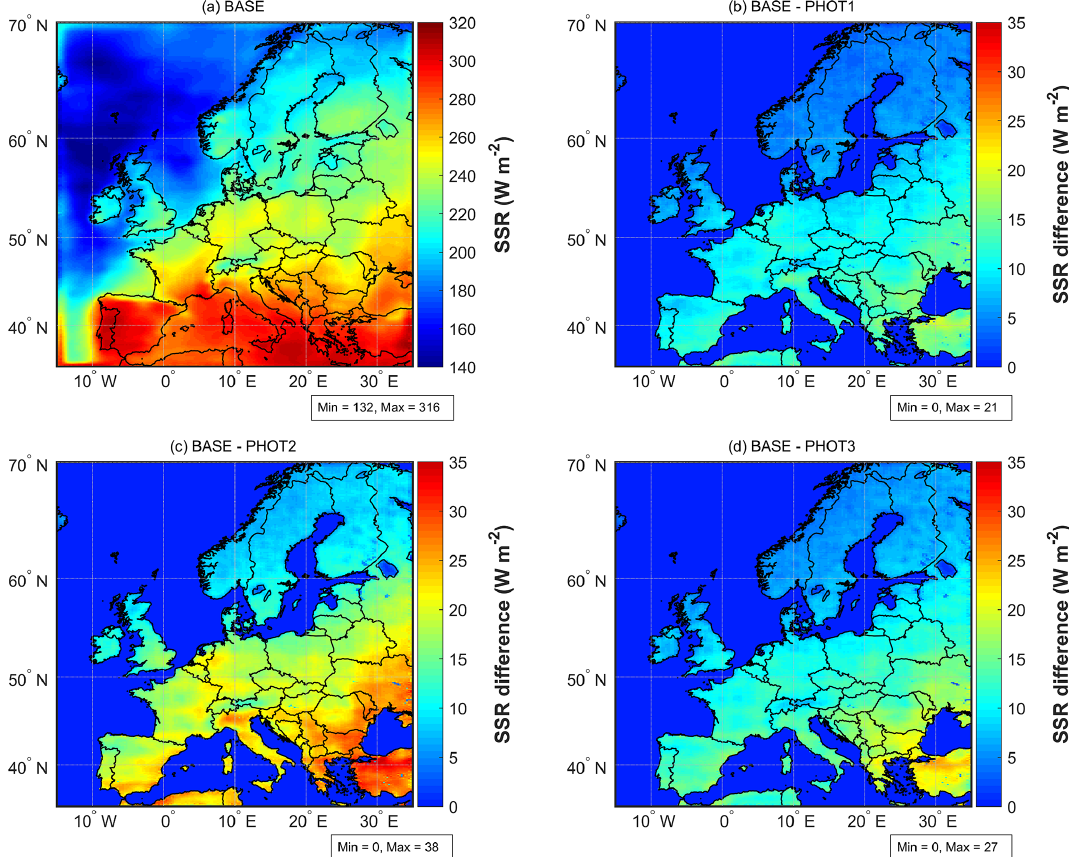
Figure 5. Seasonal daily mean SSR for the BASE scenario (a) and SSR differences between the BASE scenario and the PHOT1, PHOT2 and PHOT3 scenarios (b–d) , respectively, in summer 2010. Note the different color scale between panel (a) and panels (b–d)